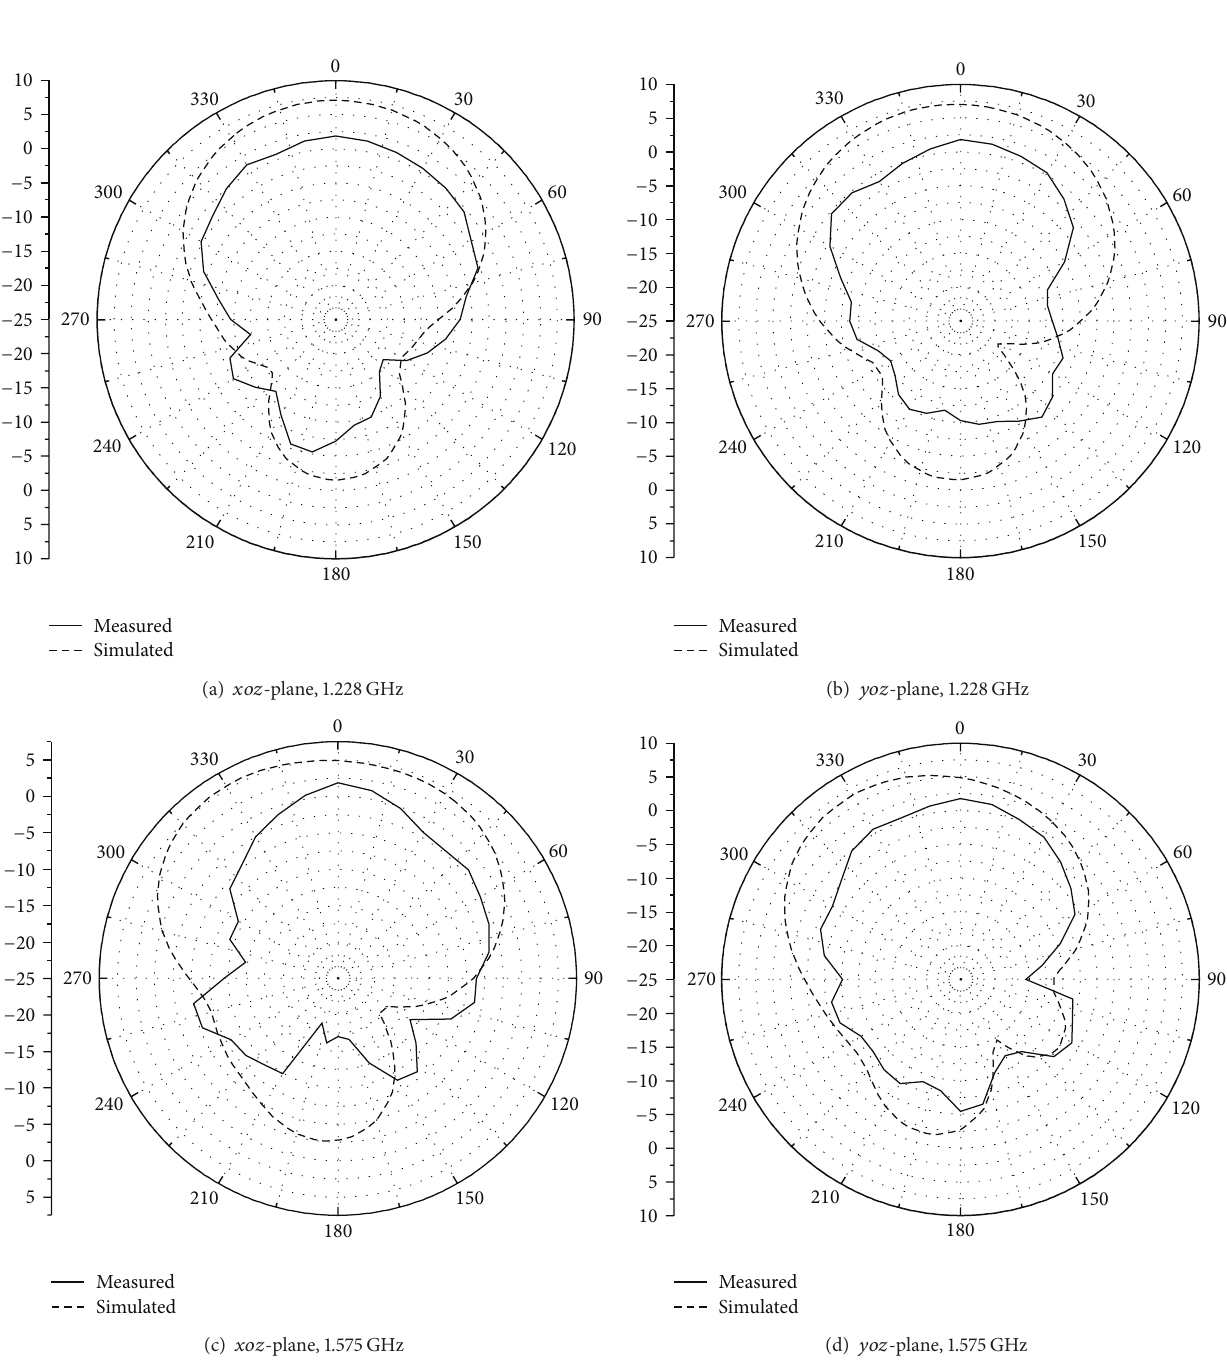
Figure 17: Measured and simulated results of radiation pattern after adding the reflecting